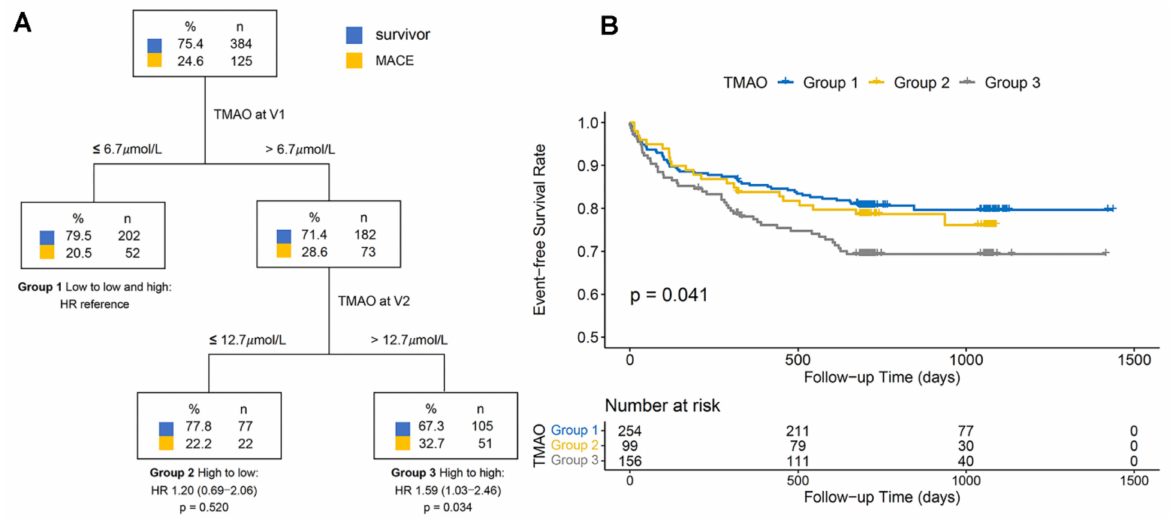
Figure 3. Decision tree of risk stratification for major adverse cardiovascular events (MACE) using combined measurements at enrollment (V1) and follow-up visit (V2) for trimethylamine N-oxide (TMAO) ( A ). Kaplan–Meier curve for cumulative MACE-free survival in groups generated by decision tree ( B ). Decision tree using plasma TMAO level at V1 as the initial classifier, followed by plasma TMAO level at V2 enables effective selection of low- and high-risk groups of patients and increased cumulative event risk in Group 3 compared to Group 1. The number of events is shown below. Data are presented as adjusted hazard ratio (HR) and 95% confidence interval (CI). The adjusted factors included age, hypertension, diabetes, peripheral artery disease, chronic kidney disease, previous history of stroke and MI, Killip II-IV, the Global Registry of Acute Coronary Events risk score, multiple vessels disease, percutaneous coronary intervention, and the peak value of cardiac troponin I and N-terminal pro-B-type natriuretic peptide during hospitalization, as well as estimated glomerular filtration rate and left ventricular ejection fraction at